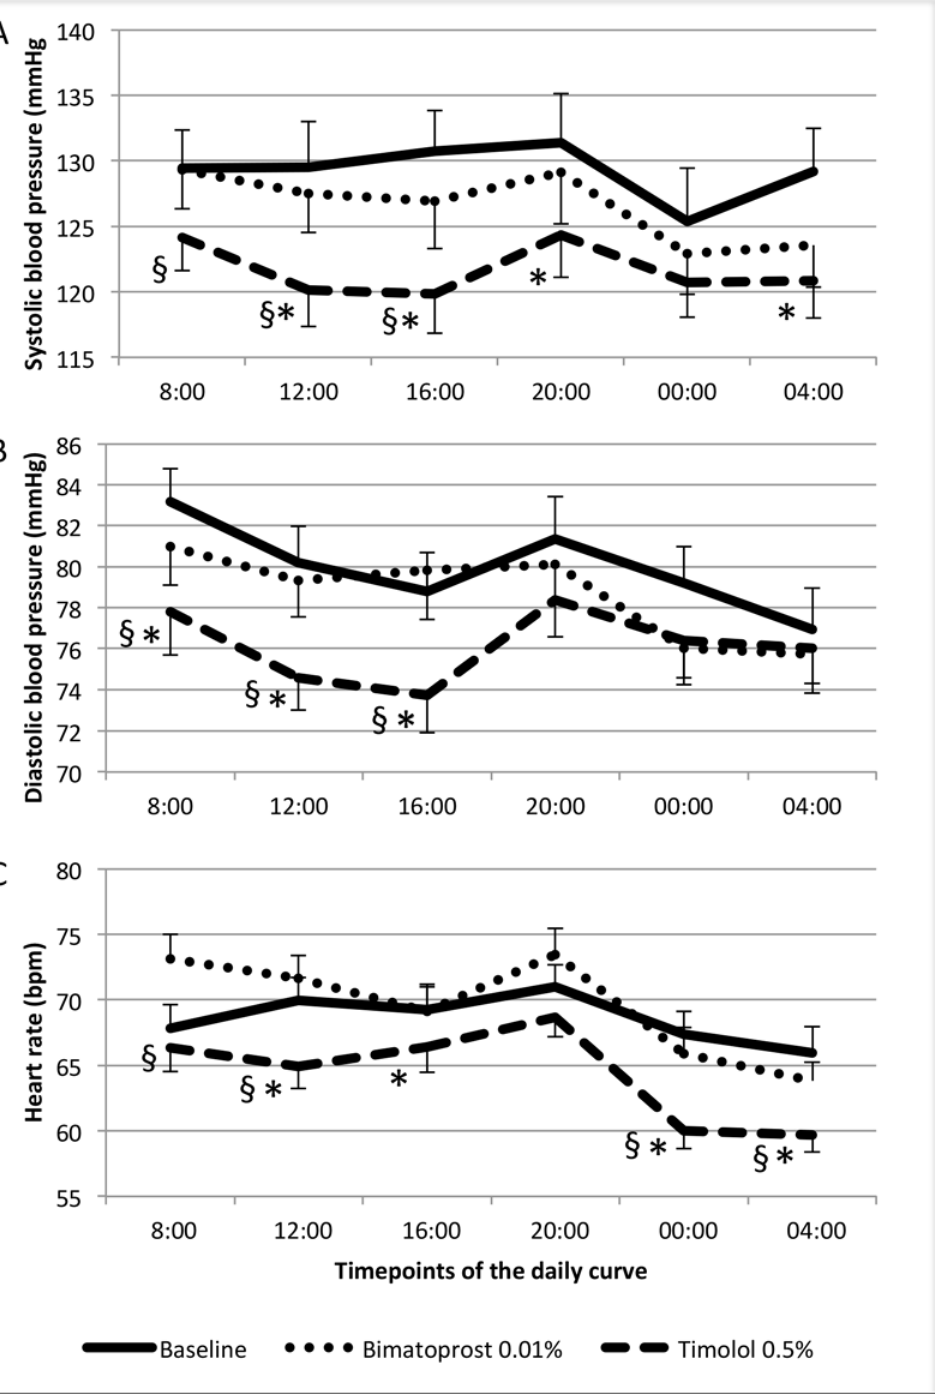
Fig 3. Systolic (A) and diastolic (B) blood pressure and heart rate (C) at each timepoint of the 24h curve at baseline (continuous line), during timolol 0.5% bid (dashed line) and during bimatoprost 0.01% plus placebo treatment (dotted line). Bpm = beats per minute. Error bars represents standard error; * = p < 5% for timepoint comparison versus baseline; § = p < 5% for timepoint comparison between timolol 0.5% bid and bimatoprost 0.01% plus placebo.